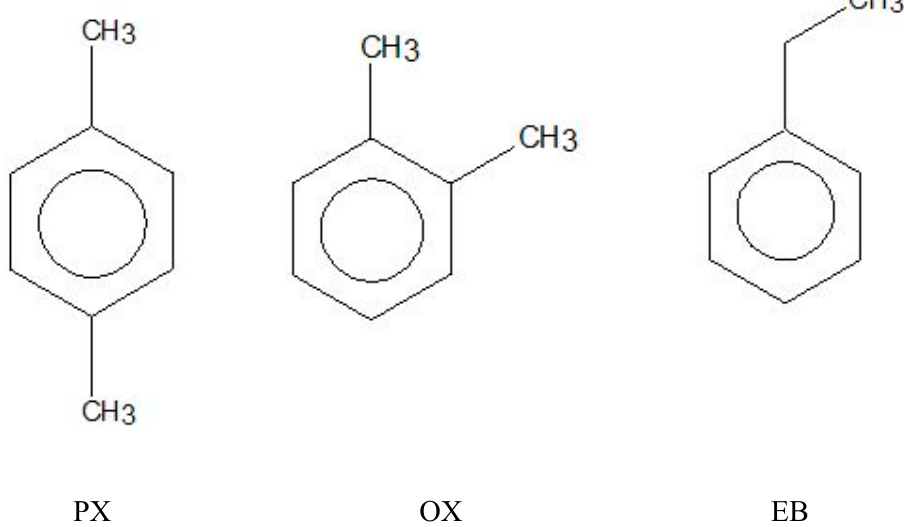
Figure 3. Chemical structures of p -xylene (PX), o -xylene (OX) and ethylbenzene (EB).